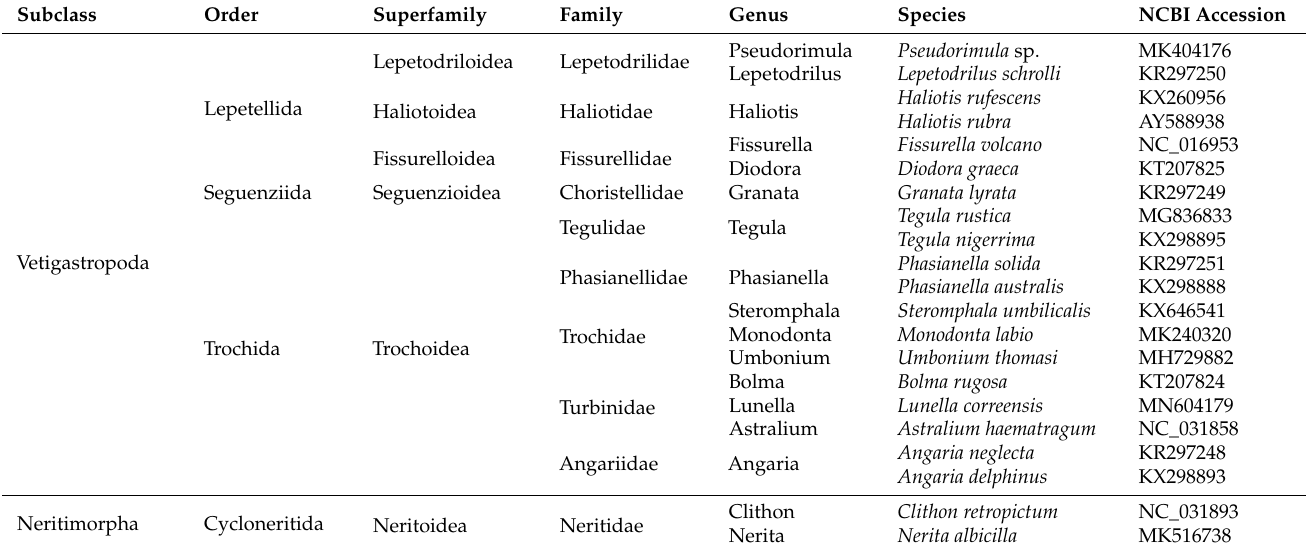
Table 1. Information of species for phylogenetic